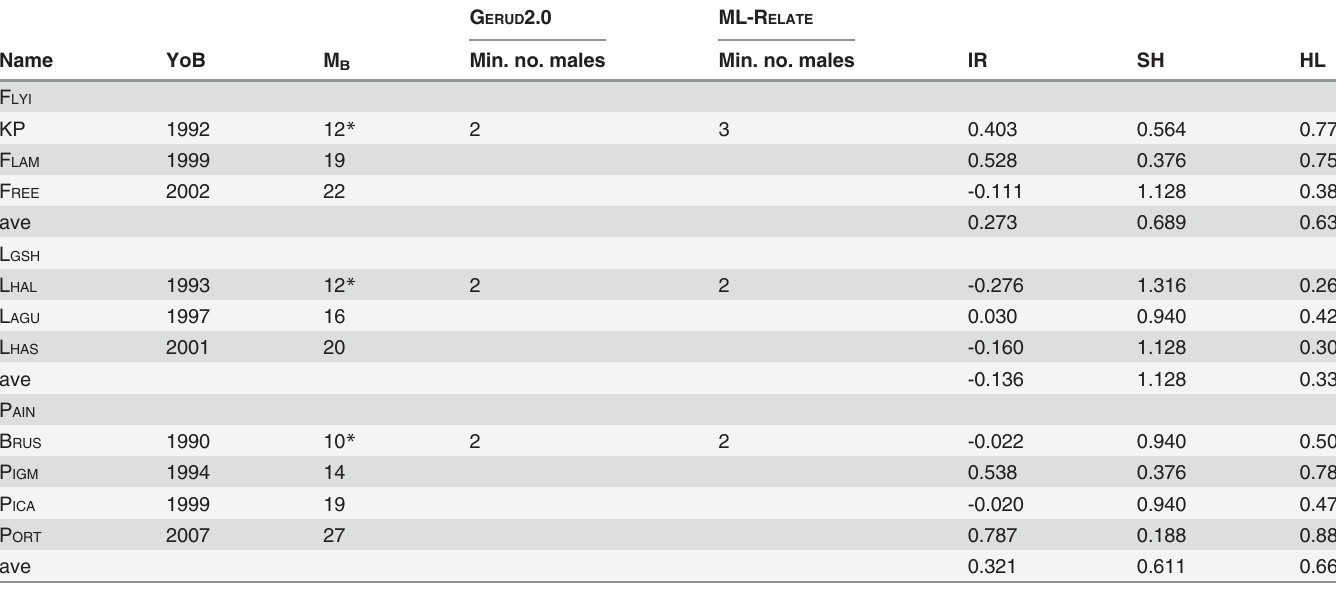
Table 1. Measures of multiple paternity and parent relatedness for progeny arrays of three Atlantic spotted dolphin females ( Stenella frontalis ). G ERUD 2.0 ML-R